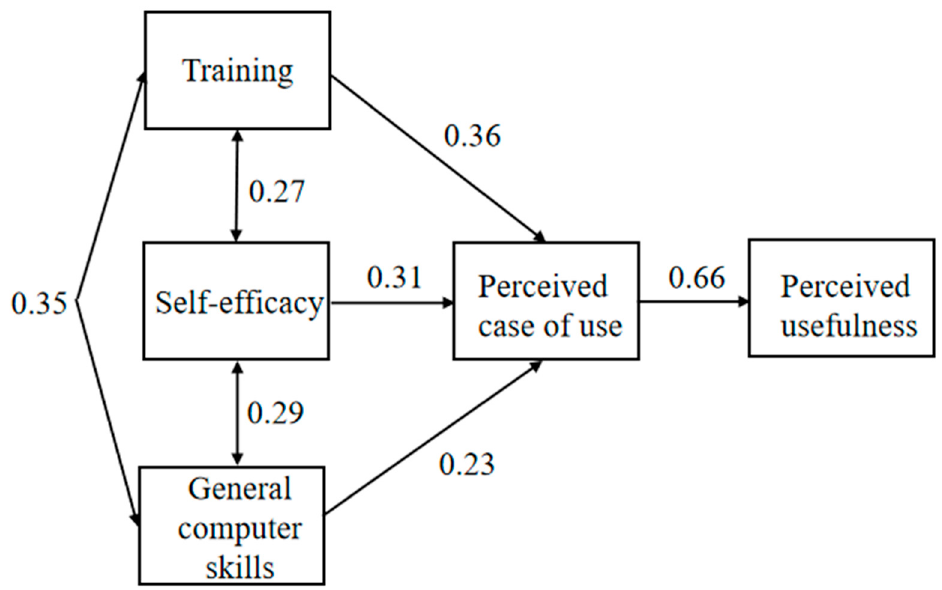
Figure 3. Observed Figure 3. Observed model.